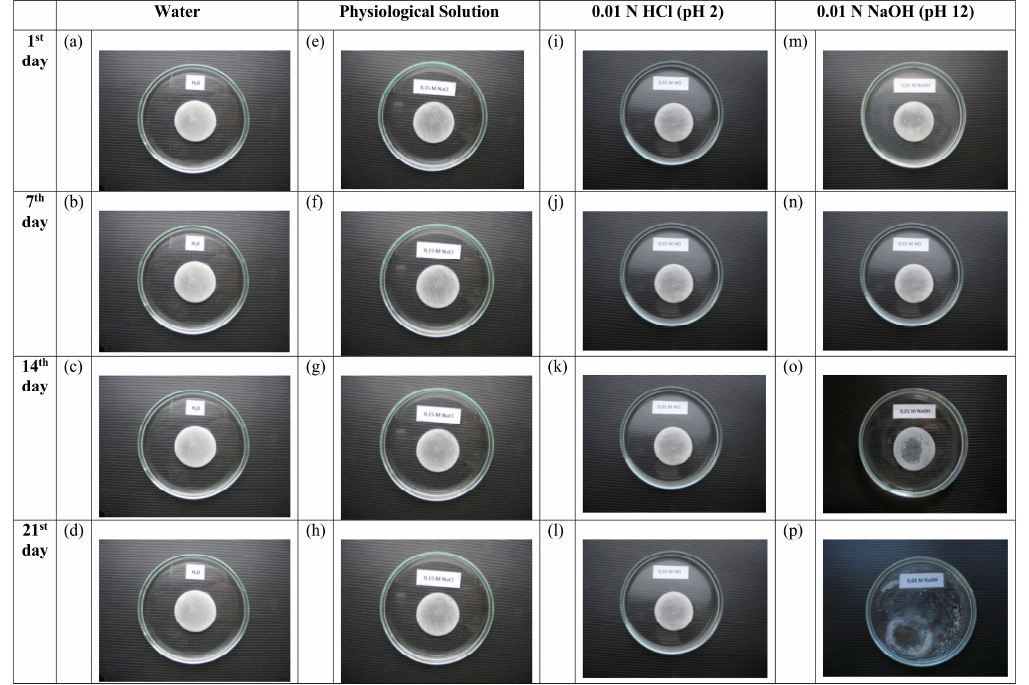
Figure 6. Appearance of the Ca-ACRS disks prepared by freezing at − 20 °C of an aqueous Na-ALG solution (30 g/L), when the resultant disks were incubated in the liquid media of different composition. The symbols ( a )–( p ) indicate the particular samples are under discussion within the text.